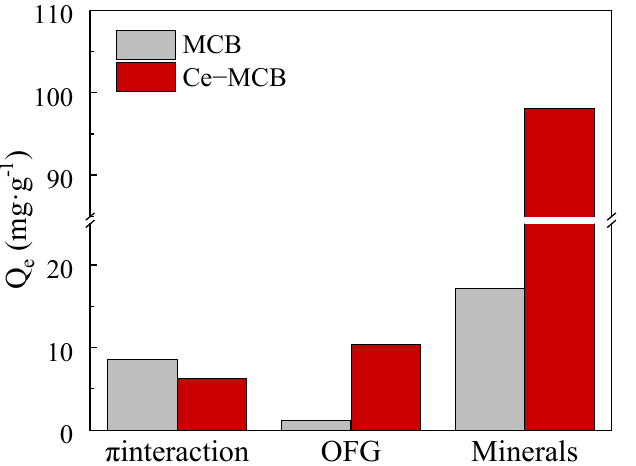
Figure 20. Quantitative study on the mechanism of Pb 2+ absorption by MCB and Ce-MCB.